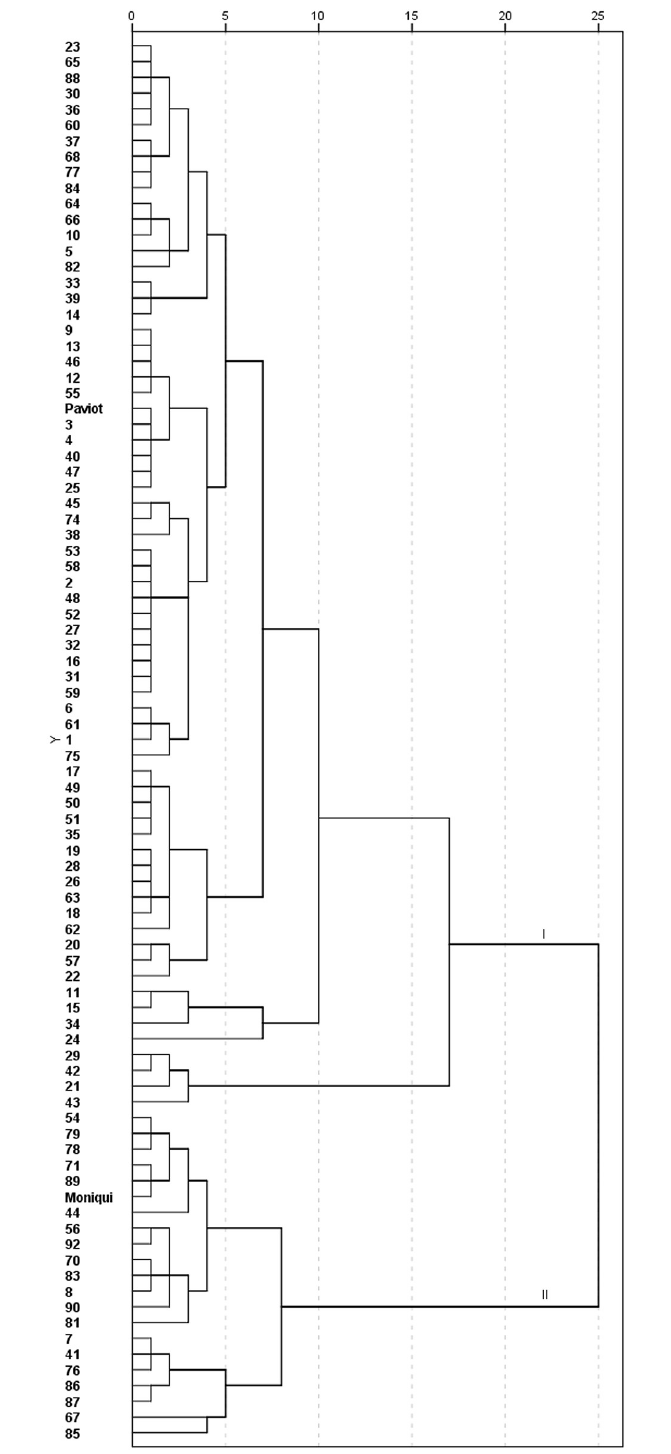
Fig 2. Cluster analysis of the F 1 apricot progeny ‘Moniqui’ x ‘Paviot’ grafted on the rootstock ‘Marianna 2624’ based on the phenotypic parameters necrotic line, wood and bark discontinuity one year after grafting.